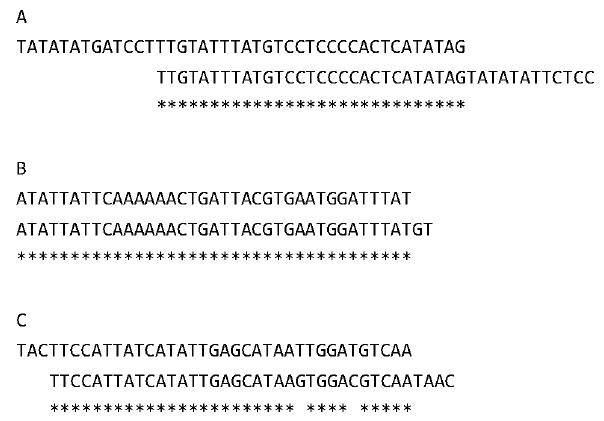
Figure 2. Summary of the CRISPR spacers end sequences in 39 S.islandicus strains. (A) A schematic of the CRISPR region of reference genome M.16.27 [33]. Rectangles represent each CRISPR repeat-spacer locus. Core and CRISPR associated (cas) genes are indicated by grey and blue arrows respectively. A red arrow indicates a transposon insertion. The reference genome M.16.27’s CRISPR loci are named on the CRISPRdb website [50] as NC_012632_1 (C), NC_012632_1 (A1), and NC_012632_1 (A2). The reference genome M.16.4’s CRISPR loci are named NC_012726_1 (A1) and NC_012726_1 (A2). (B) The color-coded CRISPR spacer arrays from left to right are the C locus, the A1 locus, and the A2 locus, as in (A). The S. islandicus strains are listed from top to bottom in the same order as in Figure 1. Each box represents a CRISPR spacer, with the spacer positions numbered at the top of the column. The leader end spacers are oriented on the left of each locus while the trailer end spacers are oriented on the right of each locus. Identical spacers in the same spacer context are vertically aligned and given the same color in the column of boxes. White boxes represent missing data and a line through a white box indicates a gap. N in boxes represents independent acquisitions of the same virus or plasmid and D represents spacers that match a different part of the same virus.